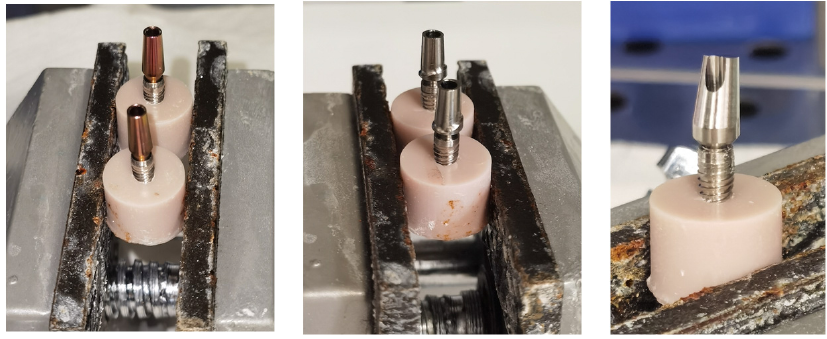
Figure 8. The three connections tested.